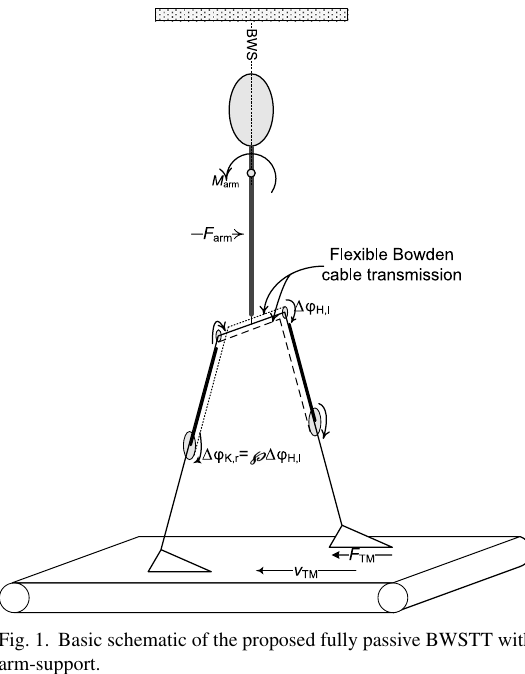
Fig. 1. Basic schematic of the proposed fully passive BWSTT with